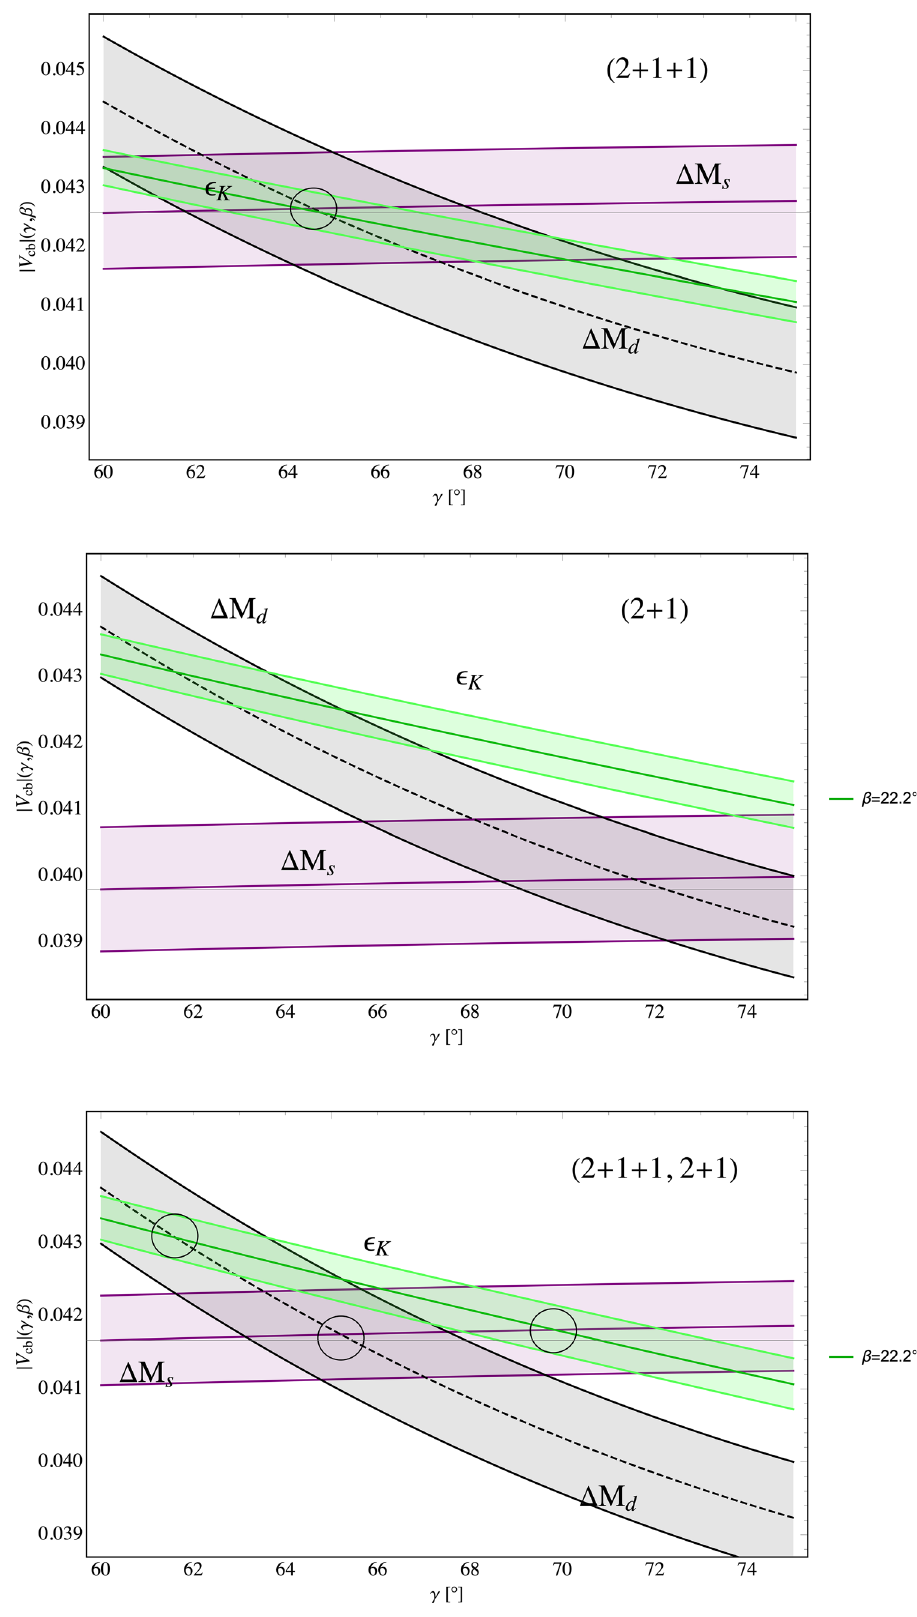
Fig. 8 The values of | V cb | extracted from ε K , (cid:2) M d and (cid:2) M γ . s as functions of 2 + 1 + 1 flavours (top), 2 + 1 flavours (middle), average of 2 + 1 + 1 and 2 + 1 cases (bottom). The green band represents experimental S ψ K S constraint on